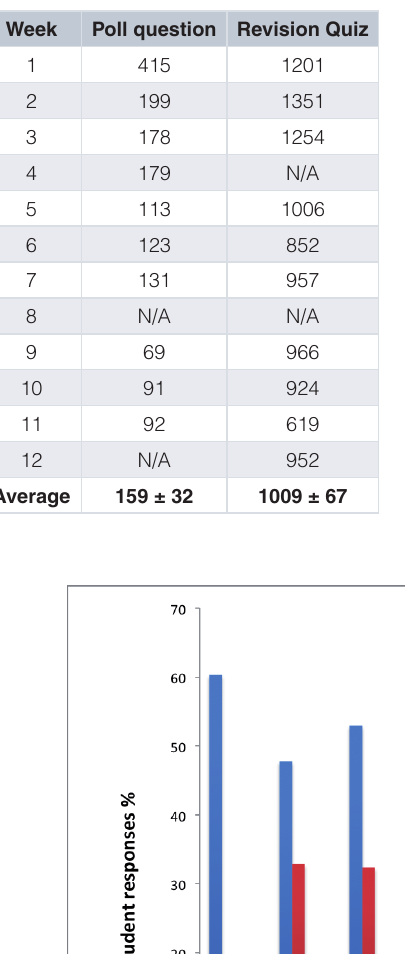
Table 1. Number of students participating in the pre-lecture poll and revision quizzes in any particular week, and the overall average (± 1 standard error). There were 763 student enrolled in the unit across three campuses. Semesters run for 12 weeks (excluding the study period). There were no lectures in Weeks 4, 8 and 12.